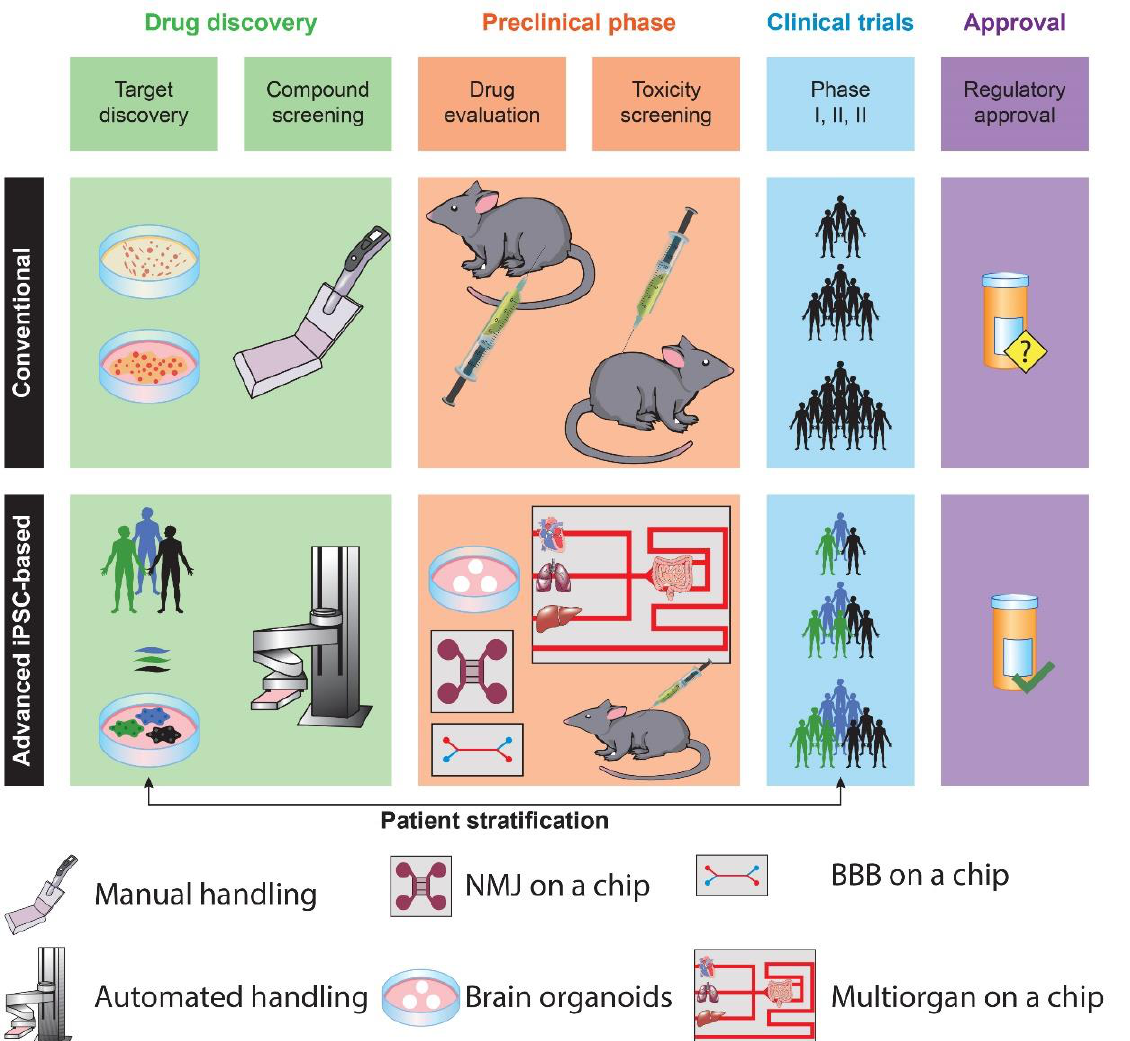
Figure 1. The conventional and iPSC-based drug discovery pipeline.